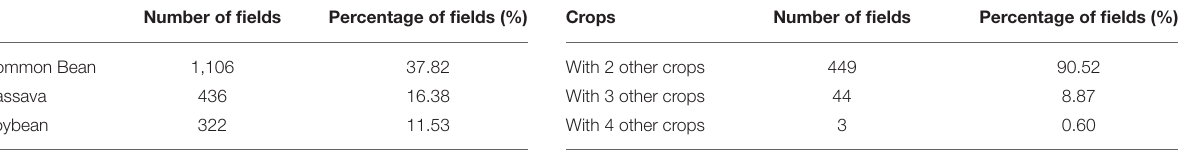
TABLE 2 | Top three field compositions of intercropped fields with one crop in season 2. Crops